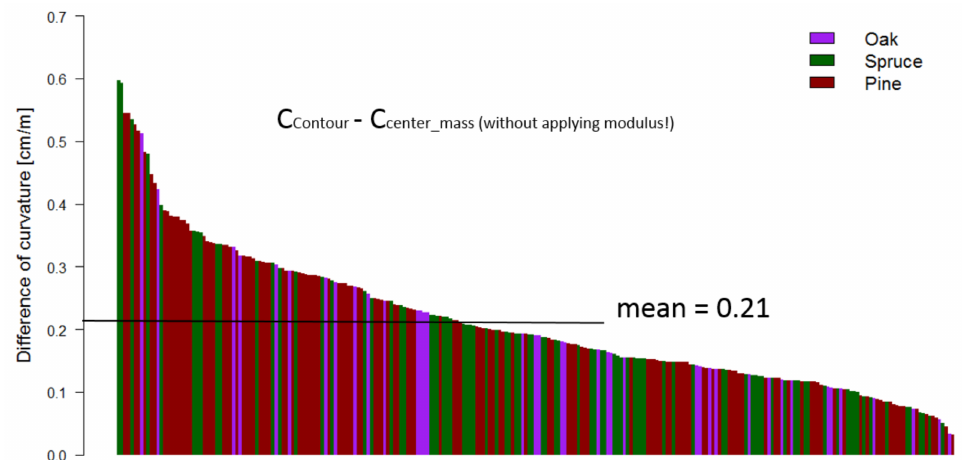
Figure A2. Differenceds between the curvature values according to the contour method (CContour) and center mass (CCenter_mass) approach for the 269 observed logs by